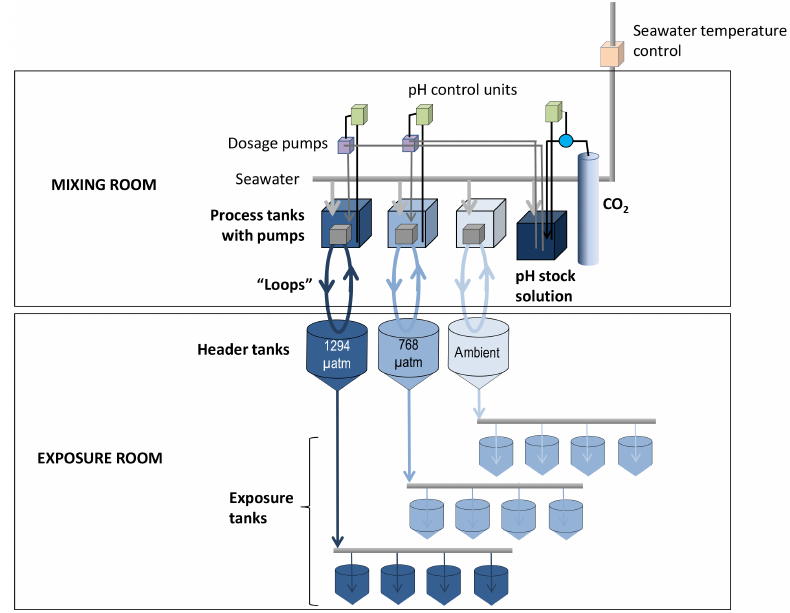
Figure 1. An overview of the experimental design showing both the mixing room for production of seawater with different levels of p CO 2 and the exposure room with fibreglass tanks for